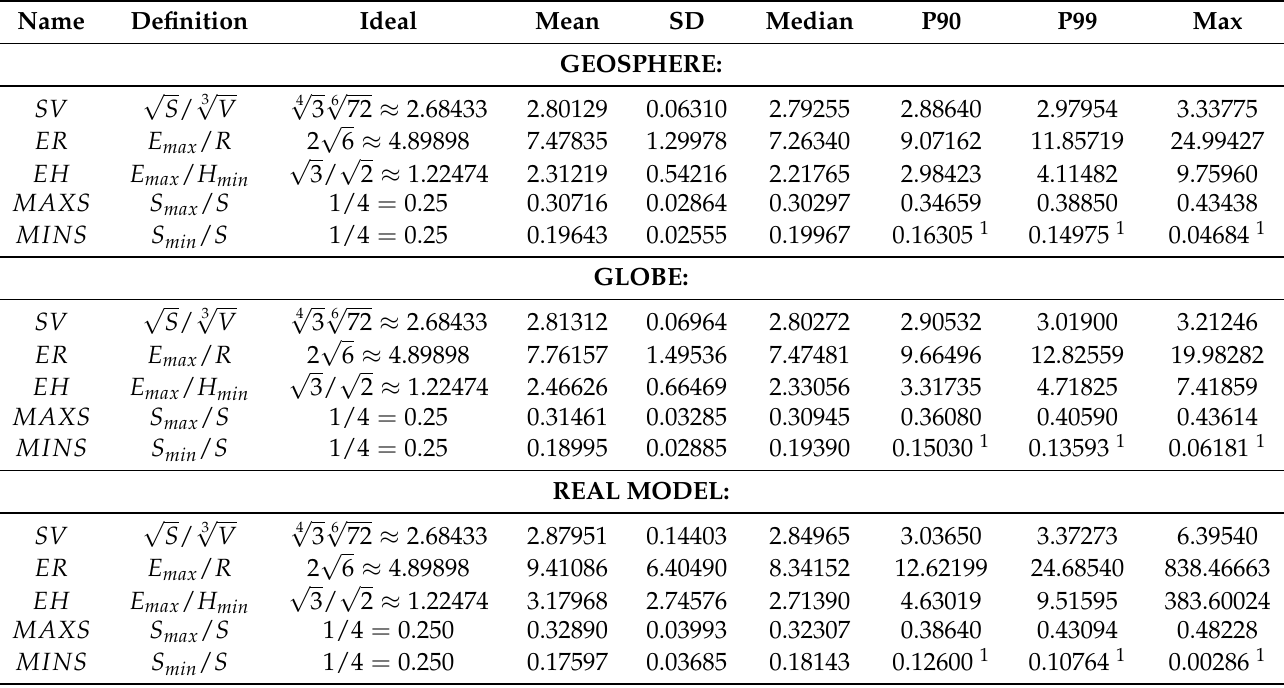
Table 10. Mesh quality measures of all the models after